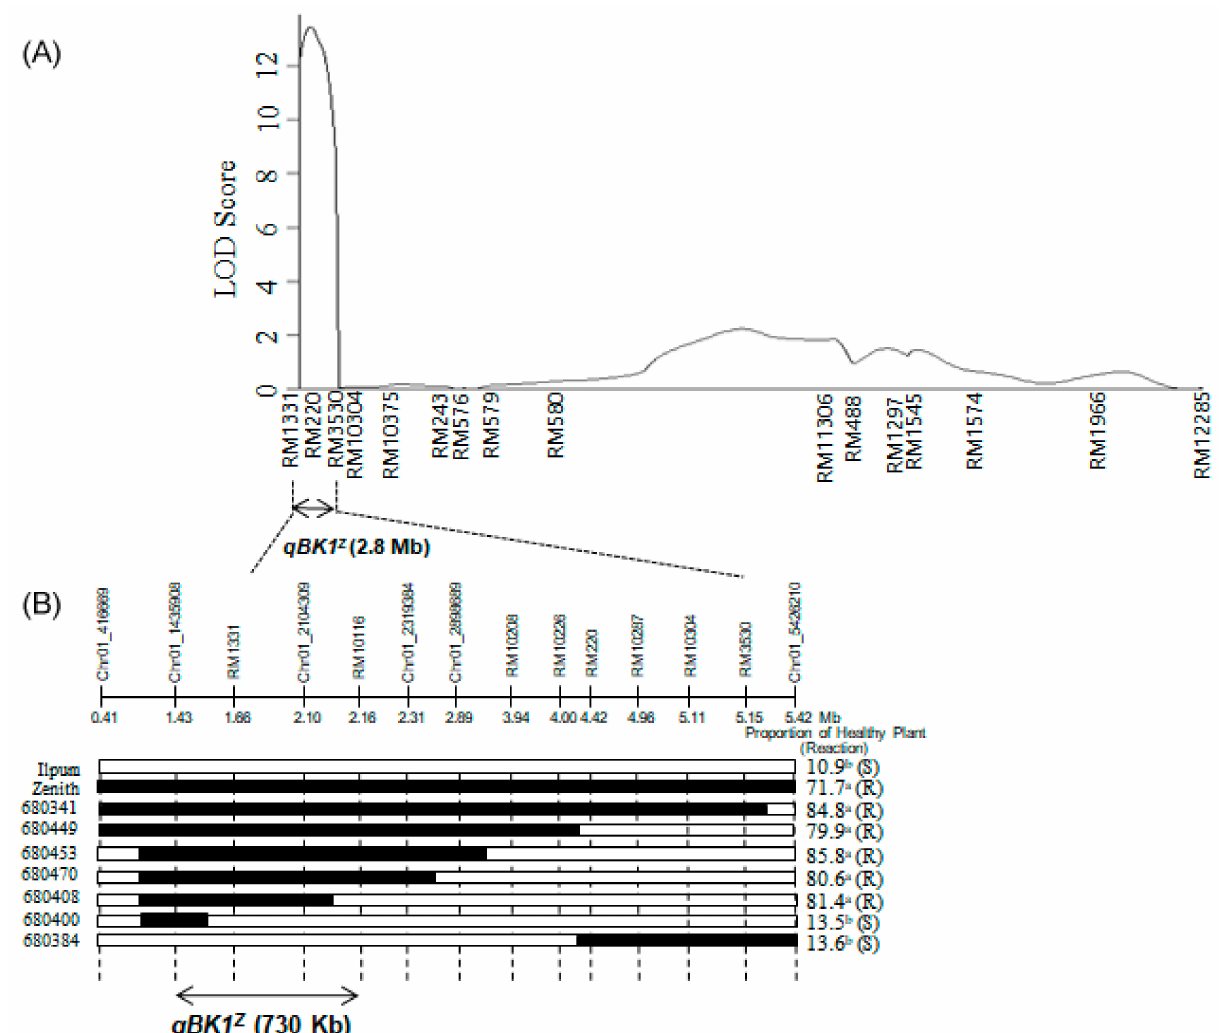
Figure 4. Quantitative trait locus (QTL) analysis of qBK1 Z on chromosome 1 using recombinant inbred lines (RILs) derived from a cross between Ilpum and Zenith. ( A ) In primary mapping, qBK1 Z was founded in the 2.8 Mb region between the RM1331 and RM3530 markers on chromosome 1. ( B ) Location of qBK1 Z was narrowed down to 730 kb region between the markers Chr01_1435908 and RM10116 in secondary mapping using seven selected homozygous recombinants. Black bars show the homozygous regions for Zenith alleles; white bars indicate the homozygous regions for Ilpum alleles; R, resistant to bakanae disease; S, susceptible to bakanae disease. The proportion of healthy plant was calculated from three biological replications. Values (%) of the proportion of healthy plant with different letters are significantly different by Duncan’s multiple range test at p =